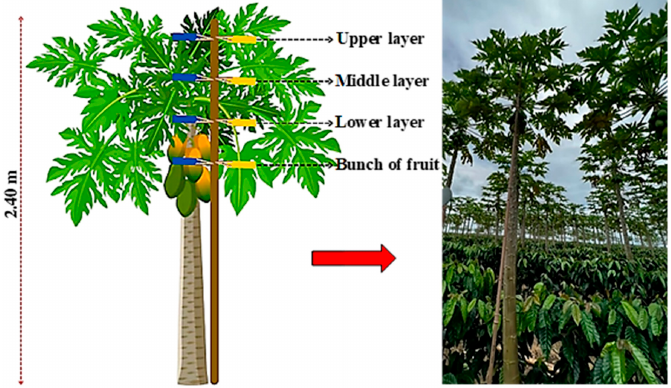
Figure 4. Arrangement of the sensitive paper labels (yellow labels) and artificial PVC targets (blue targets) at the respective evaluation heights using PVC rods. The red arrow indicates the manner in which the samples were collected.